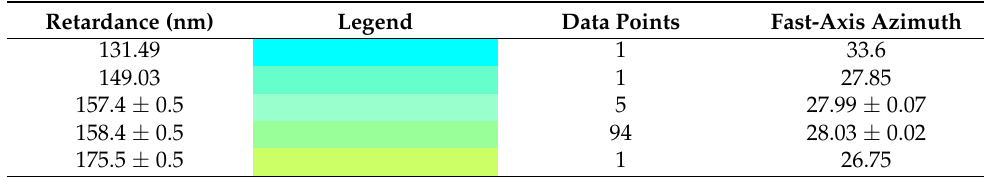
Table 1. The 1/4 waveplate parameter measurements for the entire aperture. Retardance ( nm ) Legend Data Points Fast-Axis Azimuth 131.49